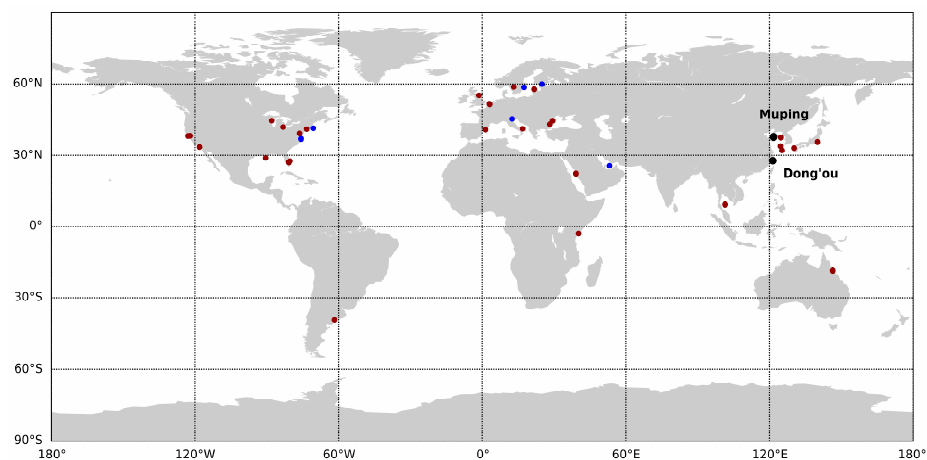
Figure 1. Locations of the initial six AERONET-OC sites (blue dots), expanded twenty-six sites (red dots), and the two fixed platforms, i.e., Muping and Dong’ou (black dots), in the Yellow Sea and East China Sea, respectively.